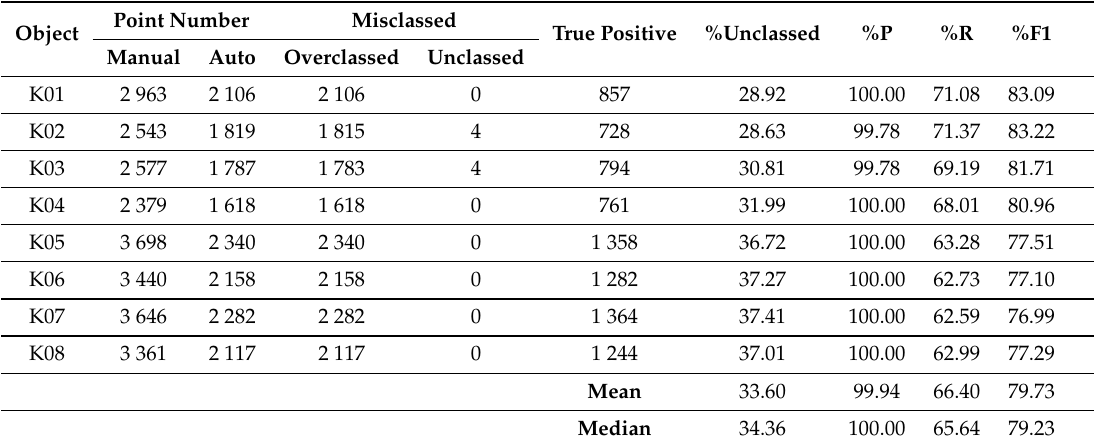
Table 4. Quantitative analysis on the results of step 2 for the detection and classification of columns in the Kasepuhan dataset. %P is precision, %R is recall, and %F1 is the normalized F1 score.